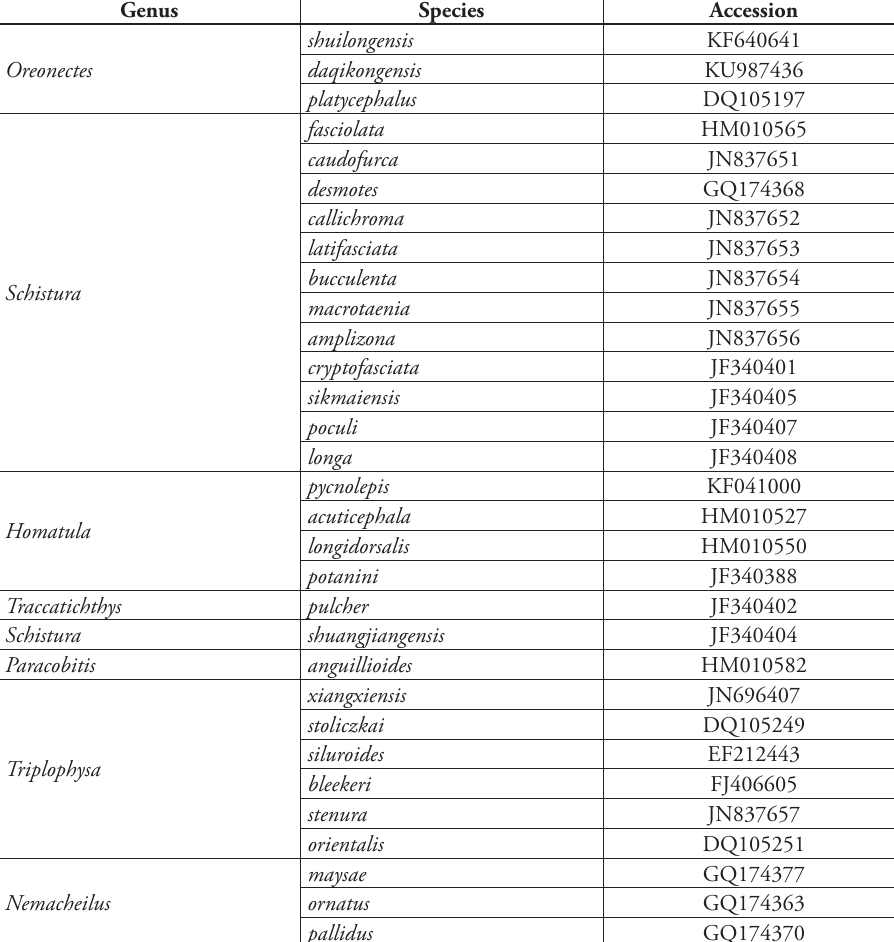
Table 1. GenBank accession numbers for the analyzed samples included in the phylogenetic